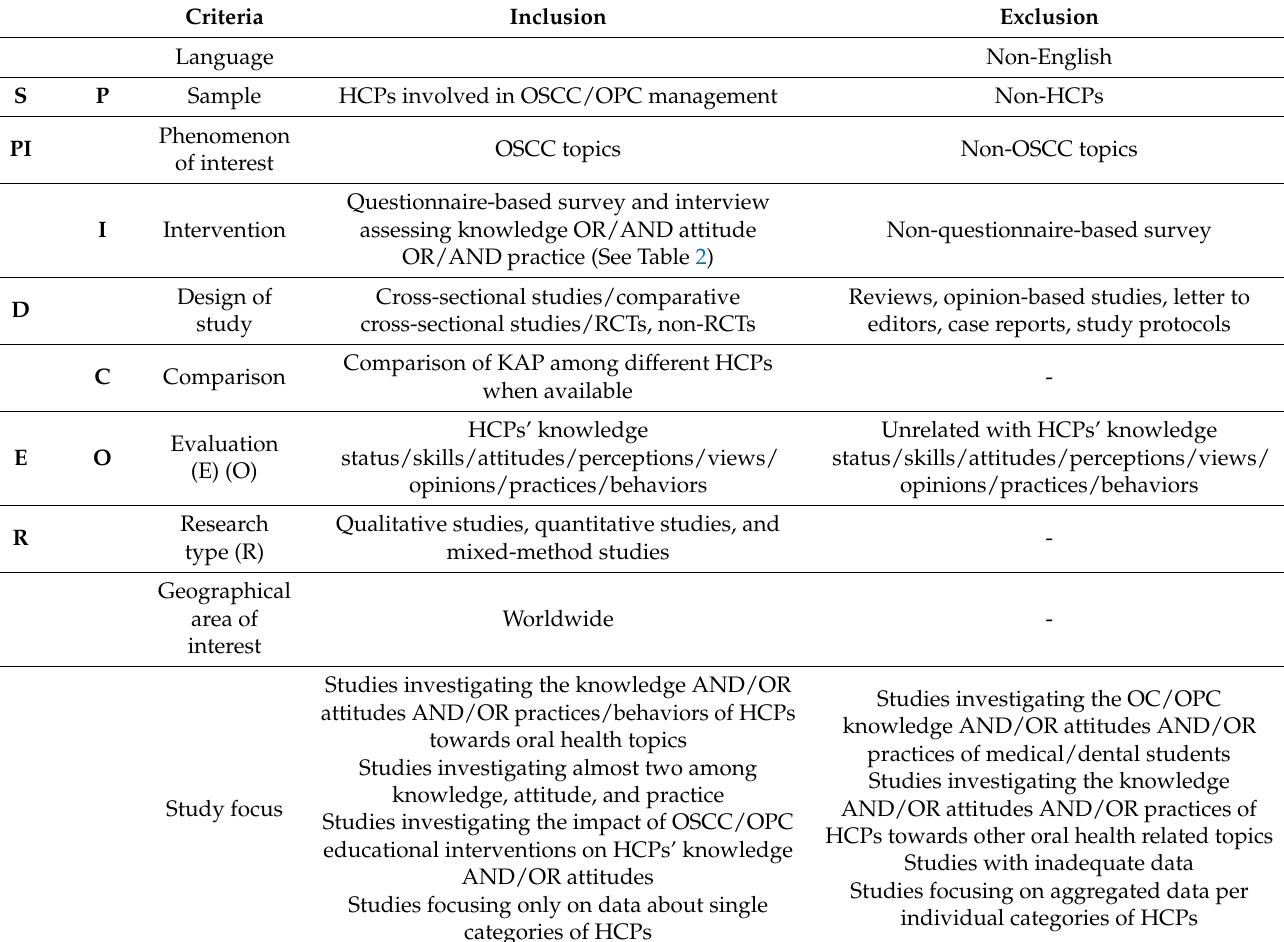
Table 1. Inclusion and exclusion